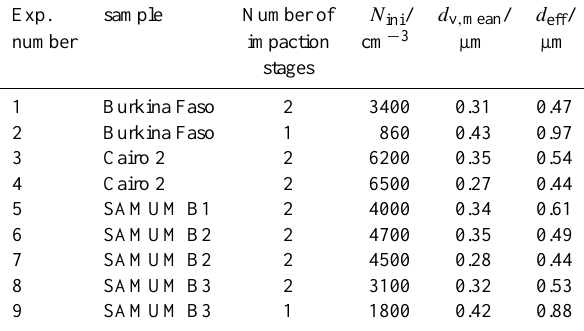
Table 1. Compilation of the initial dust particle number concen- trations, N ini , arithmetic averages of the number size distributions, d v , mean (mean particle diameter), and effective diameters (Hansen and Travis, 1974), d eff , of the aerosol size distributions for all ex- periments with the dispersed Saharan soil